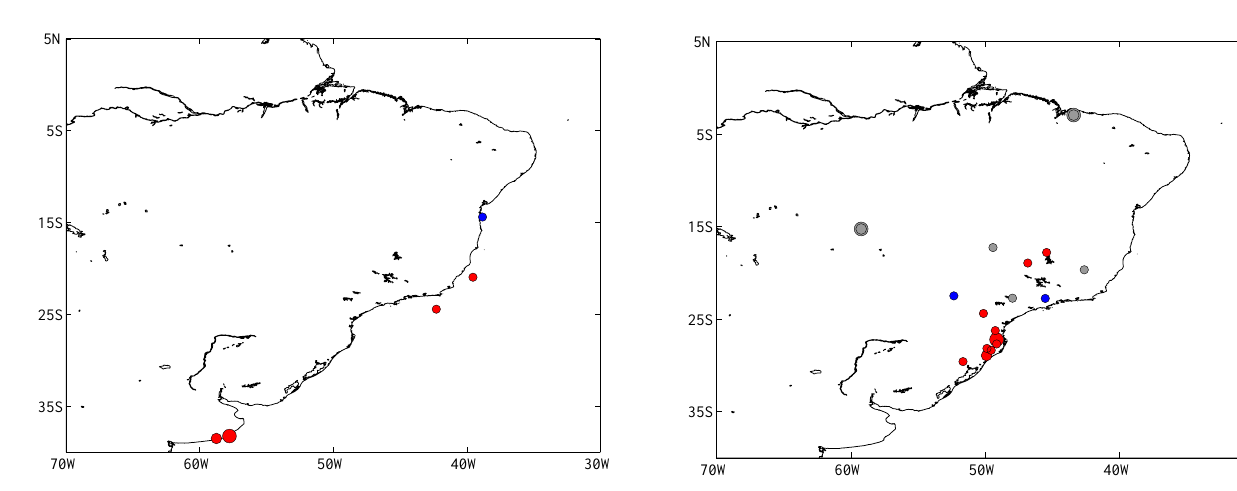
Fig. 7. MH air temperature palaeodata in eastern South America. Symbol colours: blue, colder than present; red, warmer than present; and grey, similar to present. Symbol size refers to palaeodata Q - index (a chronological reliability index; see text for more informa- tion) values; larger symbols indicate higher Q -index values. Vertical axis refers to latitude values, and horizontal axis refers to longitude